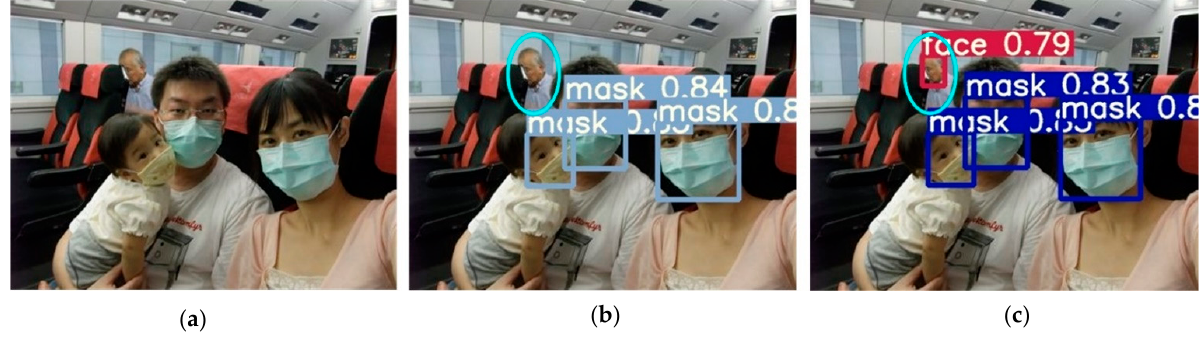
Figure 14. Detection of obscured targets. ( a ) Initial image sample; ( b ) YOLOv5 detect results; ( c ) YOLOv5-CBD detect results.